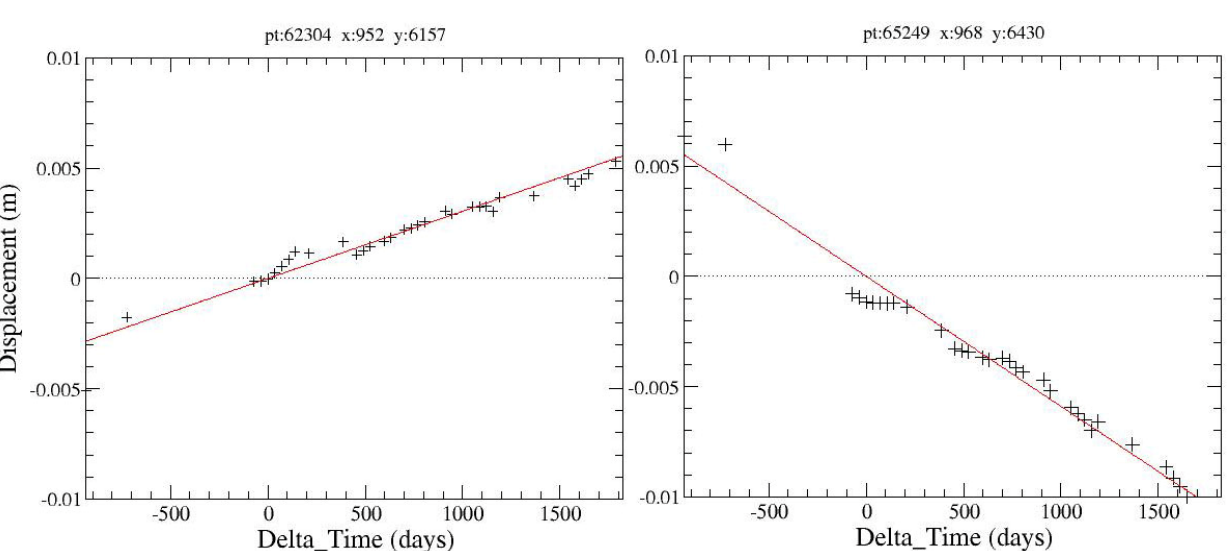
Figure 8. Typical displacement histories obtained by IPTA for specific point targets from the footwall (left diagram) and from the hanginwall (right diagram) of the Agia Triada fault zone.